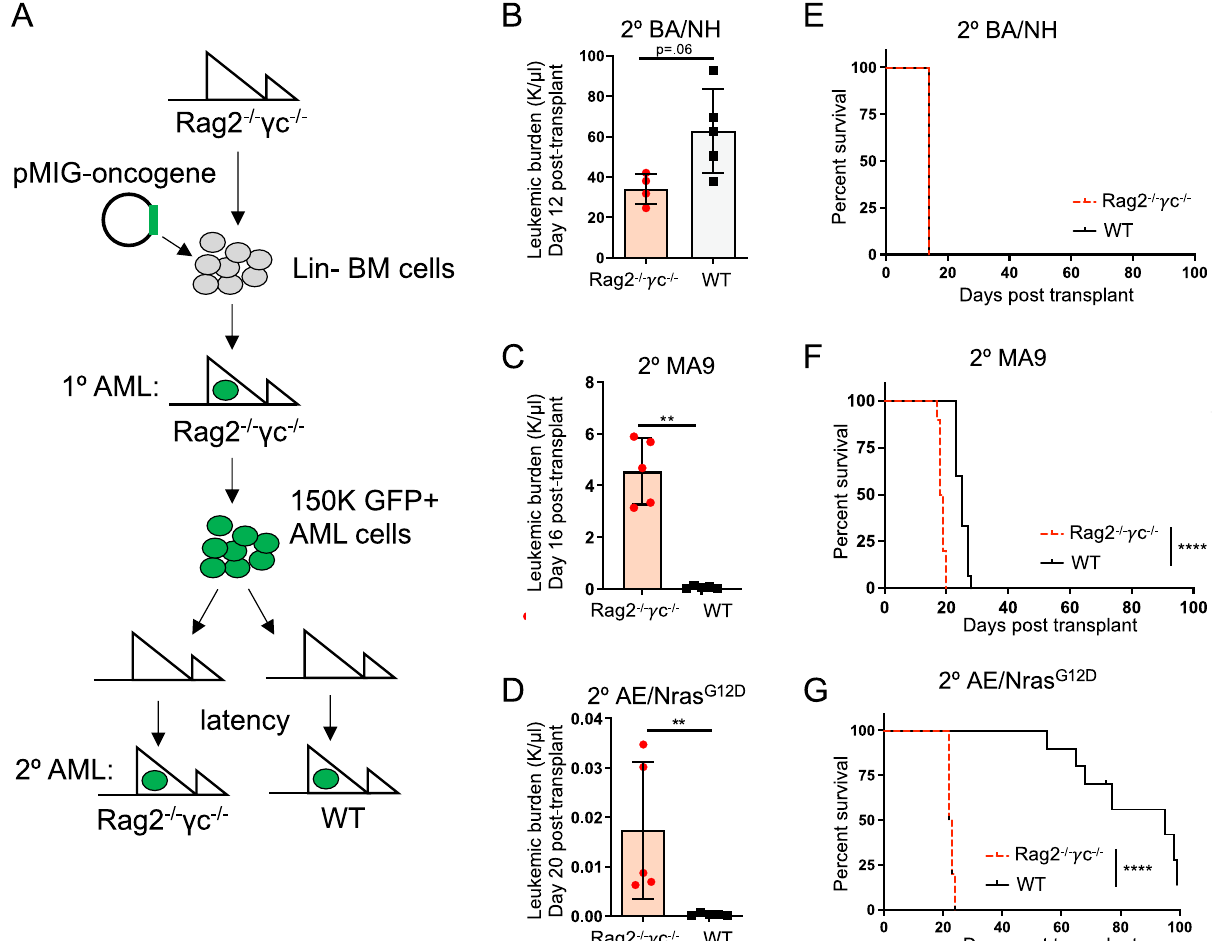
Fig.1|Oncogenespeci fi citydictatesAMLimmunogenicity.A Schemaforinvivo generation of oncogene-speci fi c retroviral 1 o AMLs in Rag2 − / − γ c − / − mice, then pas- sagedthrough2 o Rag2 − / − γ c − / − orwildtype(WT)C57BL/6Jmice.Peripheralblood(PB) leukemic burden (WBC × GFP%) of secondary recipients: B BA/NH day 12 post- transplant ( n =4 (Rag2 − / − γ c − / − ), n =5 (wildtype), p =0.0635), C MA9 day 16 post- transplant ( n =5, p =0.0079), D AE/Nras G12D on day 20 post-transplant ( n =5, p =0.0079). Data are presented as mean values+/ − SD, from one of two repeat experiments. Kaplan – Meier curves comparing survival between Rag2 − / − γ c − / −